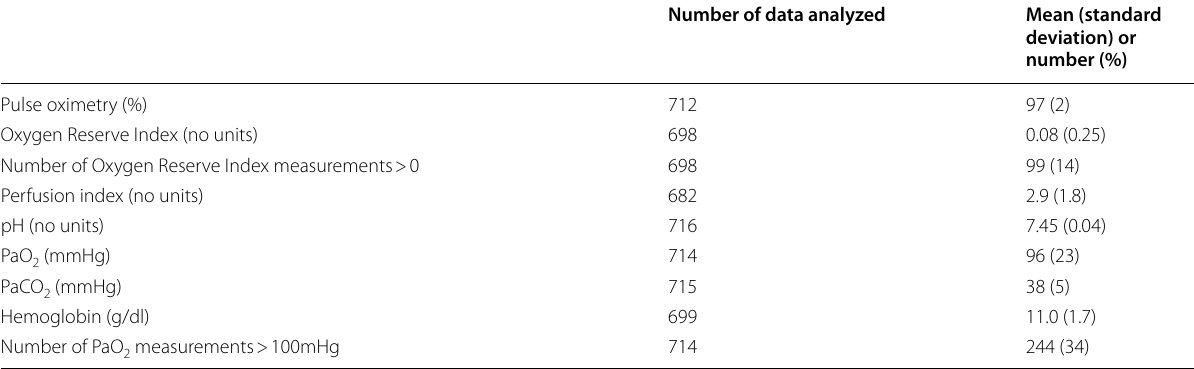
Data are expressed as mean (standard deviation) PaO 2 partial pressure of